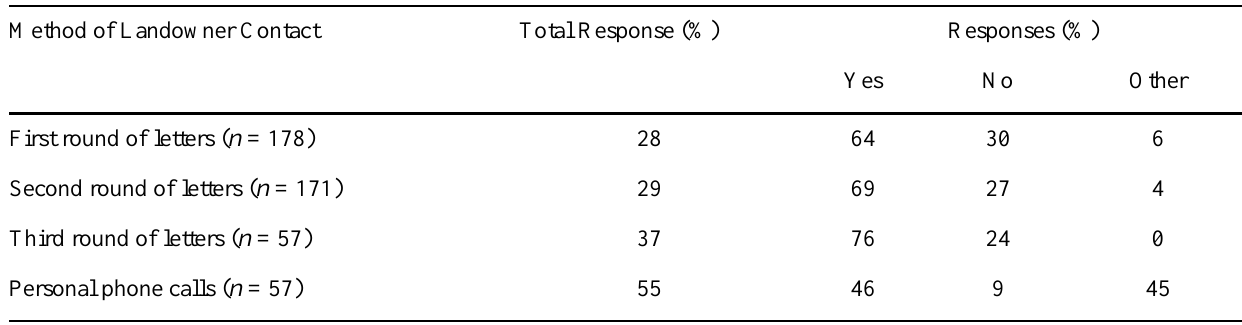
Table 1. Fish barrier assessment project landowner contacts through letters and response rate. Method of Landowner